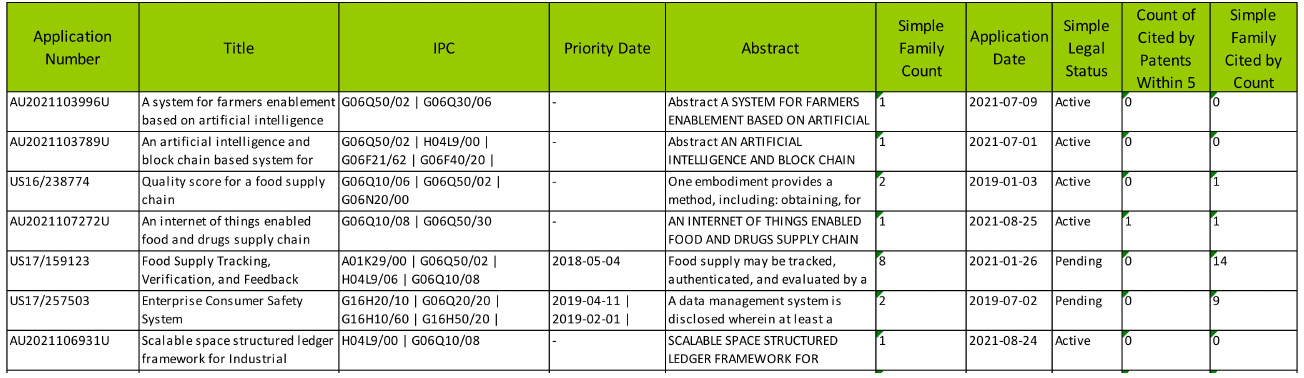
Figure 1. Screenshot of an example of a relational table for collected patent